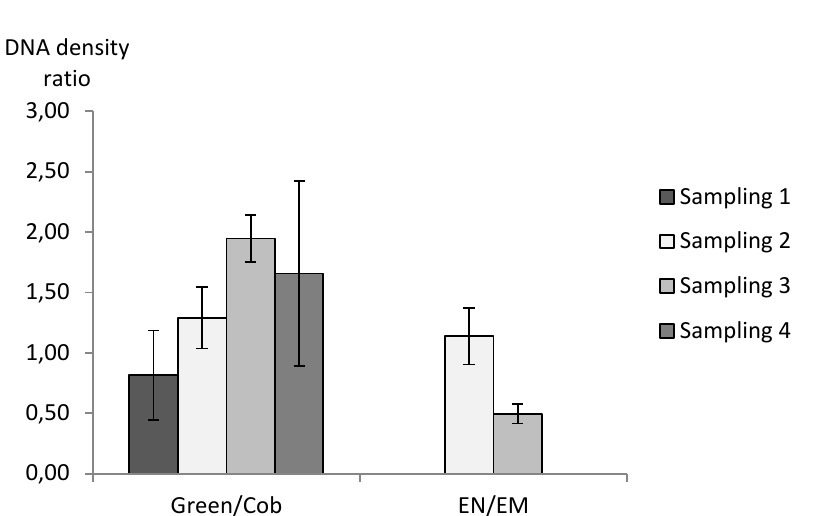
Fig. 3. DNA density ratios of different plant parts at four sampling stages. EN= Endosperm, EM = Embryo